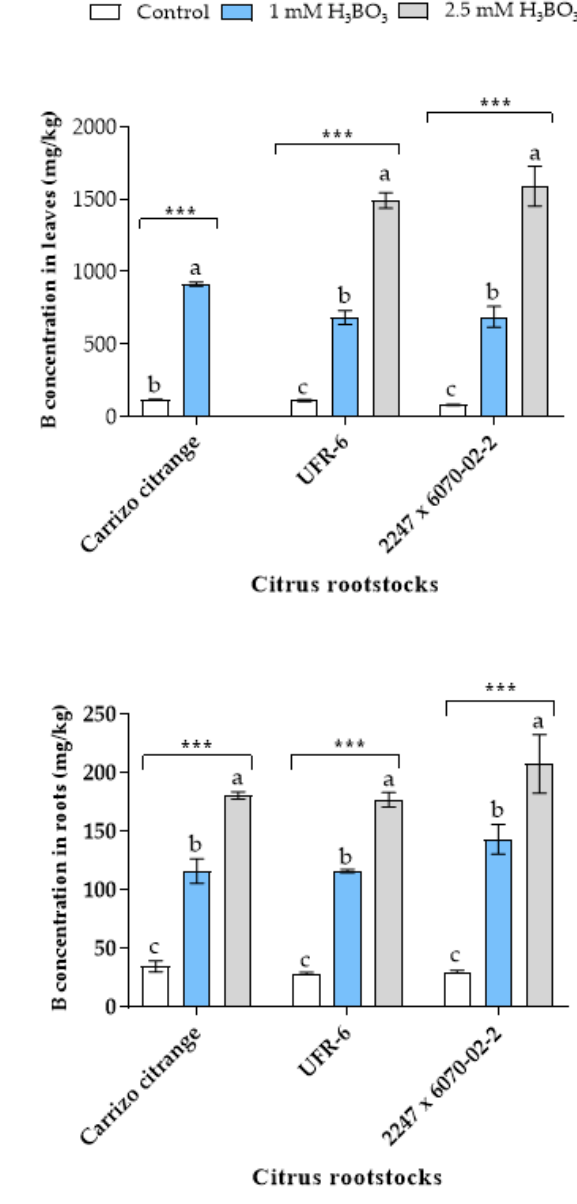
Figure 6. Mean B concentration (mg/kg) ± standard error (SE) after twenty-one days for the three rootstocks (Carrizo citrange, UFR-6 and 2247 x 6070-02-2) under three concentrations of boron treatments applied (Control, 1 and 2.5 mM of H 3 BO 3 ). ( A ) Mean B concentration in leaves. ( B ) Mean B concentration in roots. Values in columns with different letters mean statistical differences among treatments per each rootstock by Fisher’s test ( p < 0.05). 2.5 mM H 3 BO 3 treatment of Carrizo citrange leaves ( A ): data not available. Significant codes: *** = p < 0.001; ns: non-significant differences.